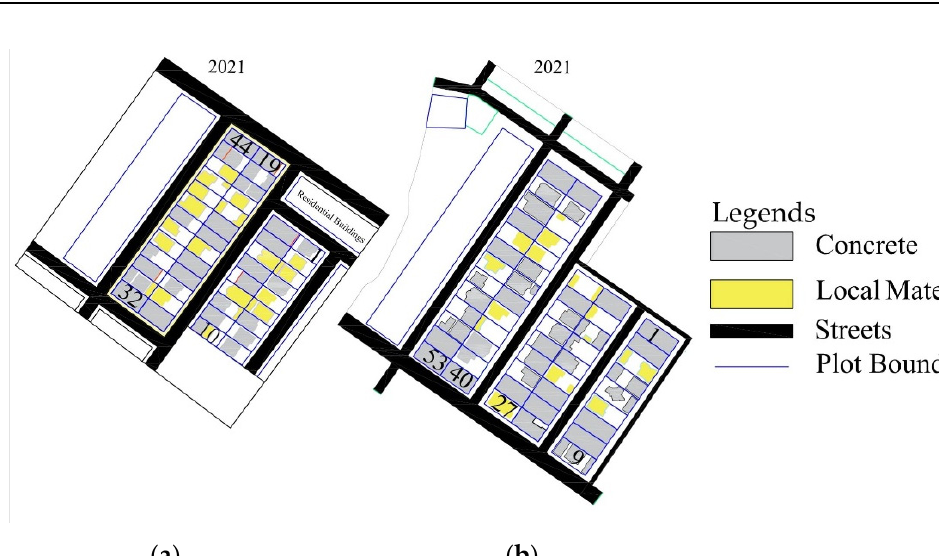
Figure 6. Housing Material in Study Areas: ( a ) Parwan-2; ( b ) Taimani.